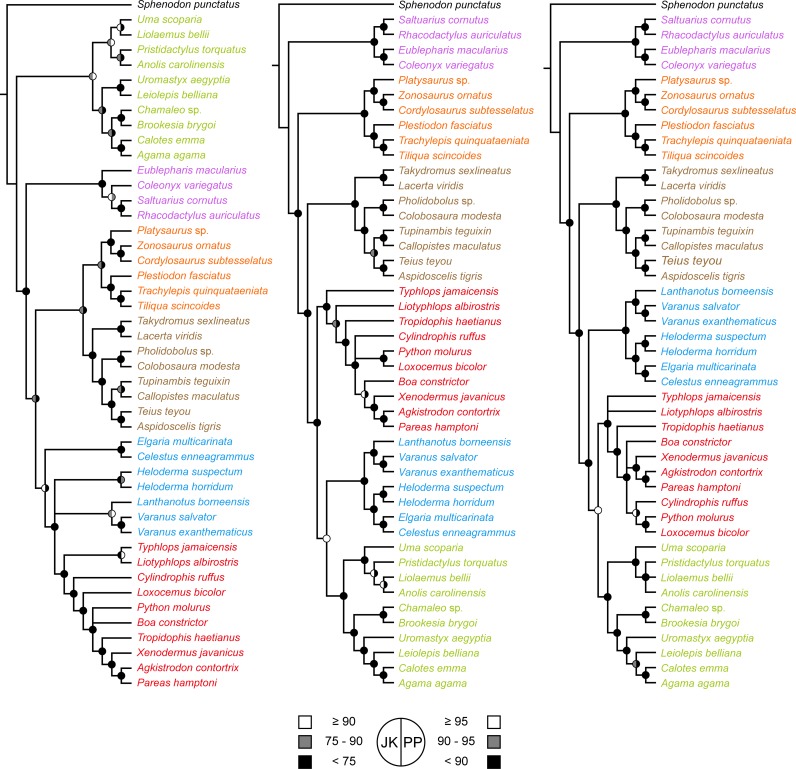
Summary of phylogenetic relationships obtained using morphological (left), molecular (center) and combined datasets (right). Topologies correspond to the strict consensus of the optimal trees under equal-weights maximum parsimony and Bayesian inference for each dataset (original trees can be found in S4 File). Main lizard clades are color coded: light blue = Anguimorpha, purple = Gekkota, green = Iguania, brown = Lacertoidea, orange = Scincoidea, red = Serpentes. Circles on nodes correspond to support values, coded as shown at the lower left corner. JK = jackknife, PP = posterior probability.